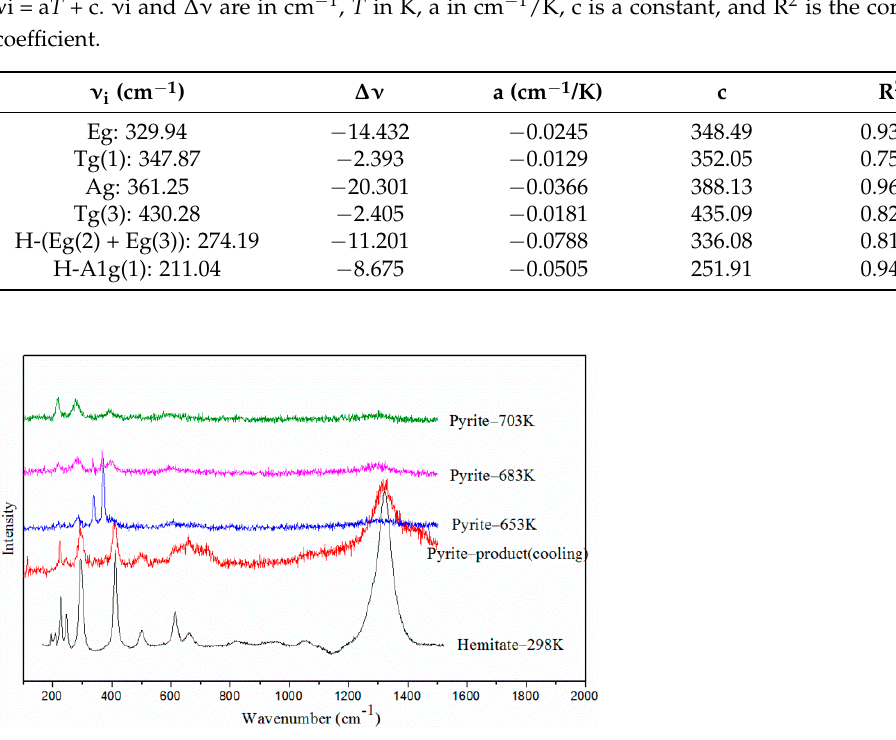
Figure 4. Raman spectra of pyrite and hematite from bottom to top: hematite at 298 K [22], increased pyrite temperature to 703 K and cooling to 298 K, pyrite at 683 K, pyrite at 703 K.